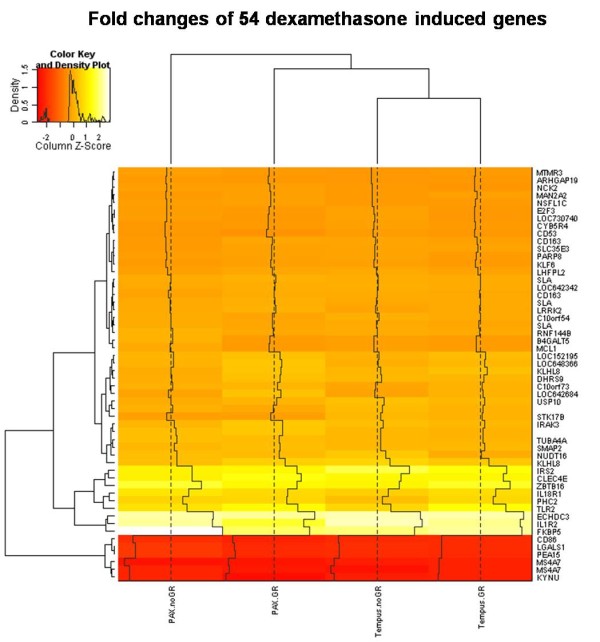
Comparison of fold changes between PAXgeneTM and TempusTM tubes after dexamethasone-stimulation: Heatmap of fold changes of 54 significantly differentially expressed transcripts after dexamethasone-stimulation in PAXgene™ and Tempus™ tubes. The legend displays the colour mapping to row-wise Z-scores, which are calculated by subtracting the mean from each cell, and then dividing the value by the standard deviation of the row. The density plot in the legend indicates that most transcripts have consistent fold changes across the 4 groups (non-significant differences are indicated in orange). Few transcripts show significant differences in dexamethasone induction as indicated in red and white. The histogram in the heatmap indicates the z-score scaling across the rows, with the dotted black line indicating a z-score of 0. The transcripts are ordered according to their z-score scaling across the rows, from the non-significant z-scores around 0 on the top and the significant z-scores around 2 at the bottom.